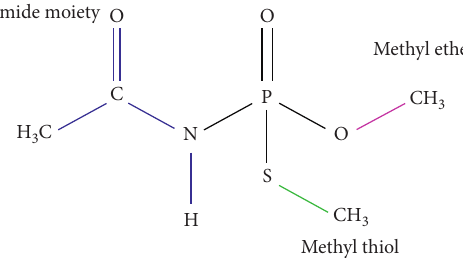
Figure 1: Ac structure with its characteristic functional